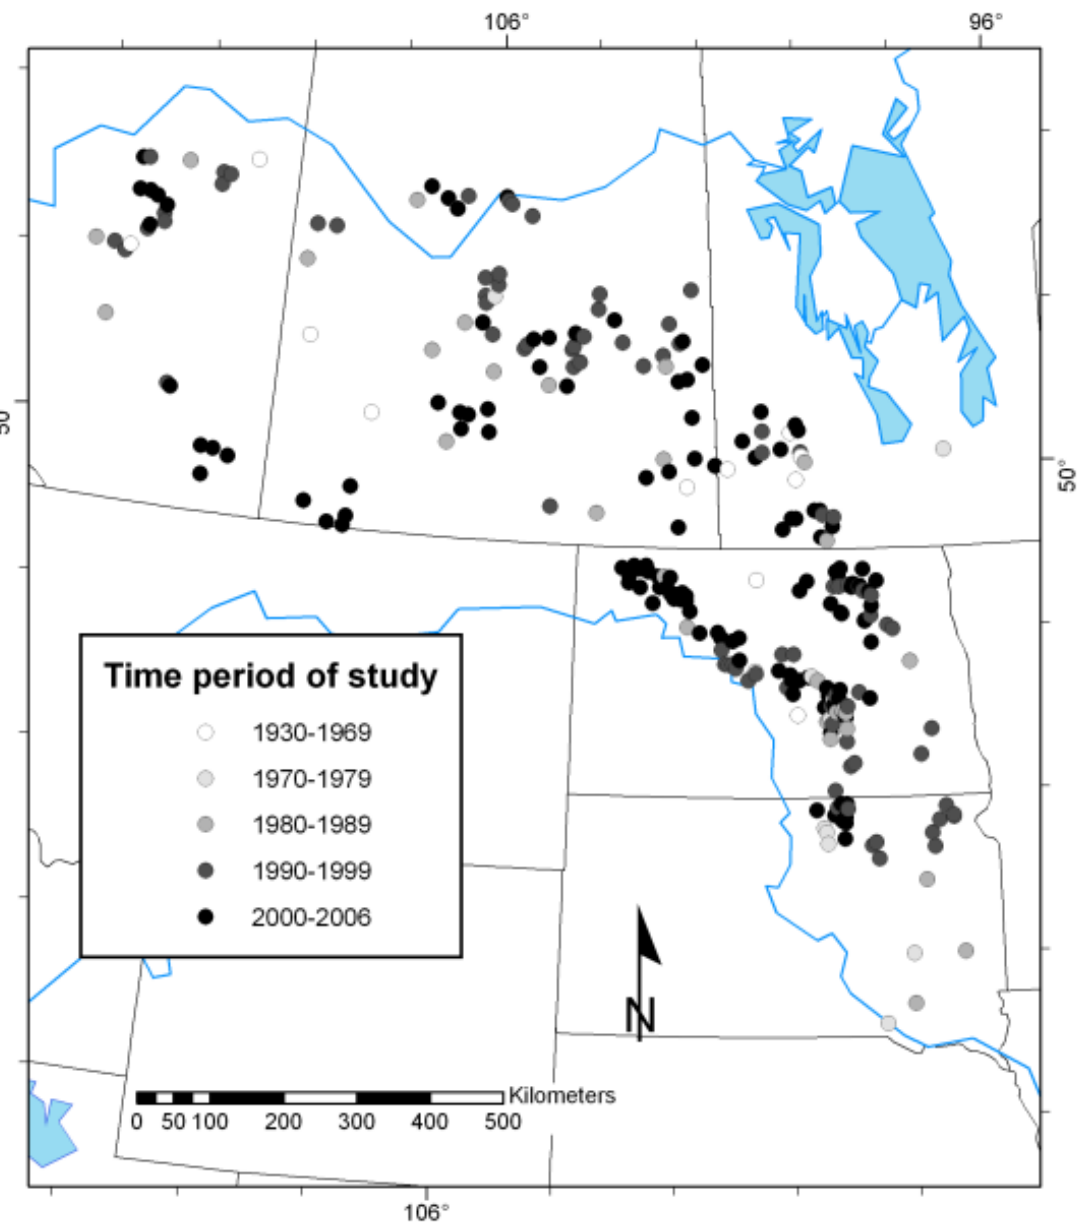
Fig. 1 . Locations of nest success estimates of dabbling ducks from the Prairie Pothole Region of North America, 1935–2006. The colors of the points indicate the time period during which data collection took place, and the lines indicate the state and provincial boundaries of the United States and Canada. The U. S./Canada border spans the 49th